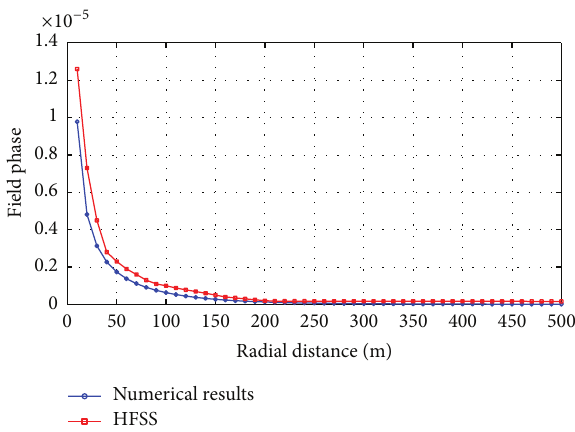
Figure 15: Curve of the total electric field phase with the radial distance by numerical results and